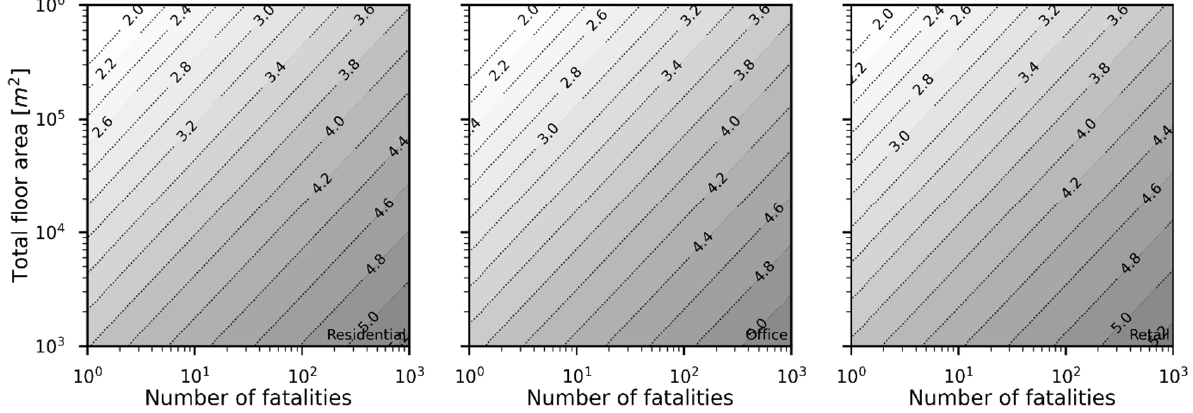
Figure 4. Reliability index in function of the number of fatalities and floor area, for residential, office, and retail use.